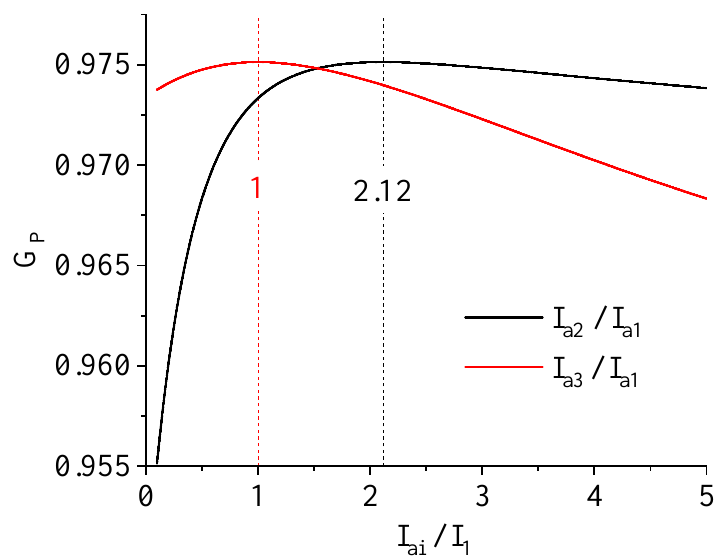
Figure 7. Case 1: efficiency calculated for Case 1 by varying the ratio of the input currents while all the other parameters are set to the optimal values.